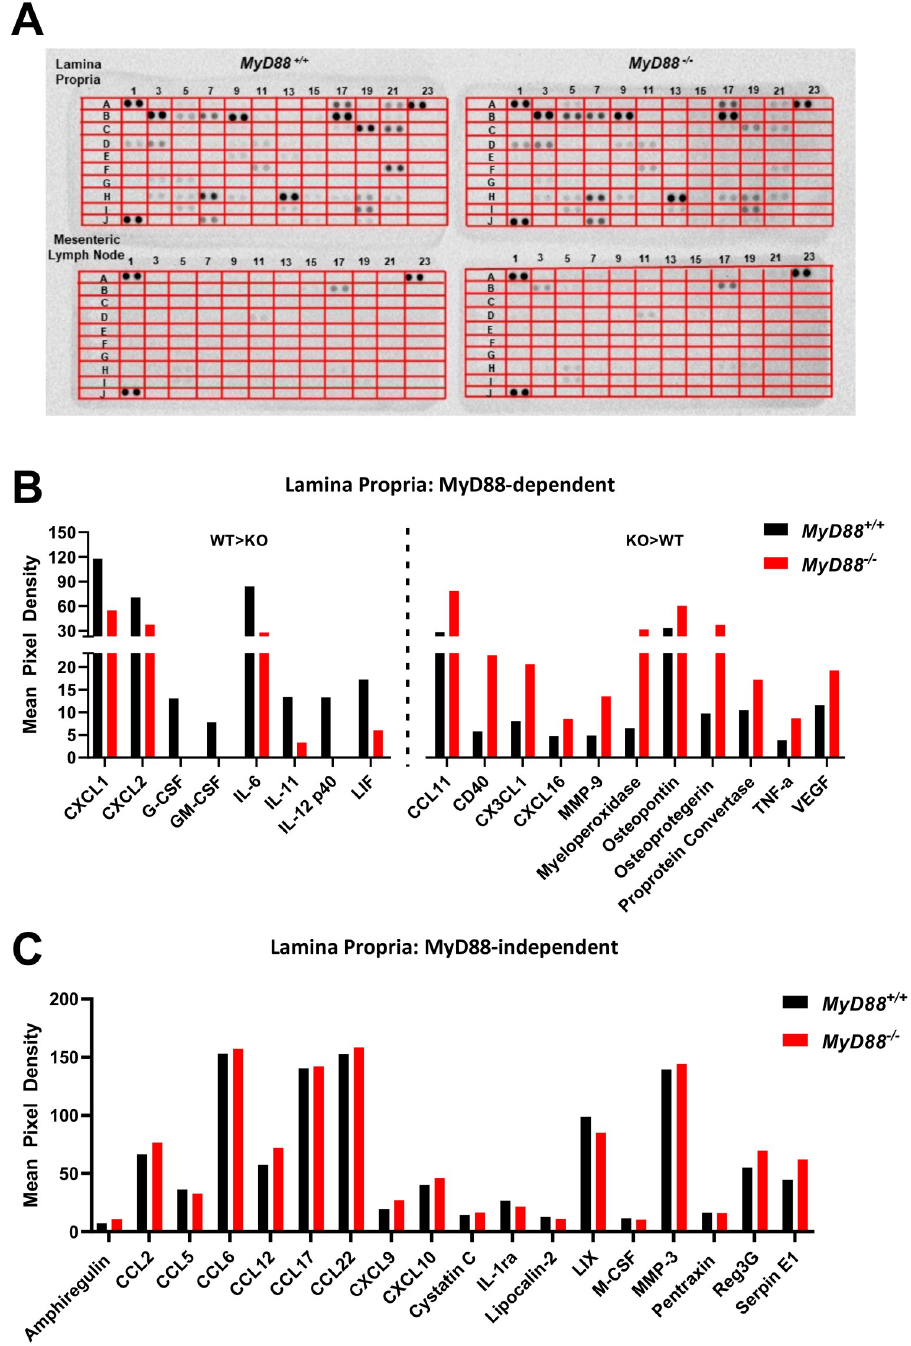
Fig 1. T . gondii induces both MyD88-dependent and MyD88-independent cytokine and chemokine responses in the intestinal mucosa. Lamina propria (LP) cells from MyD88 +/+ and MyD88 -/- mice were isolated at day 7 post-oral infection with 40 ME49 cysts and cultured ex vivo without further stimulation for 72 hrs. (A) The resulting supernatants were collected, pooled, and analyzed for cytokines and chemokines using a commercial proteome array. Mean pixel densities of MyD88-dependent LP responses (defined as 1.7-fold change or greater between mouse strains) were plotted (B) and compared to MyD88-independent responses (C). Only cytokines and chemokines with mean pixel densities above background are displayed. Supernatants were pooled from cells derived from 4 mice/group.